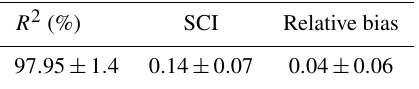
Table 1. Error statistics for the simulated profiles by XBeach com- pared with the measured profiles during Riskbeach.